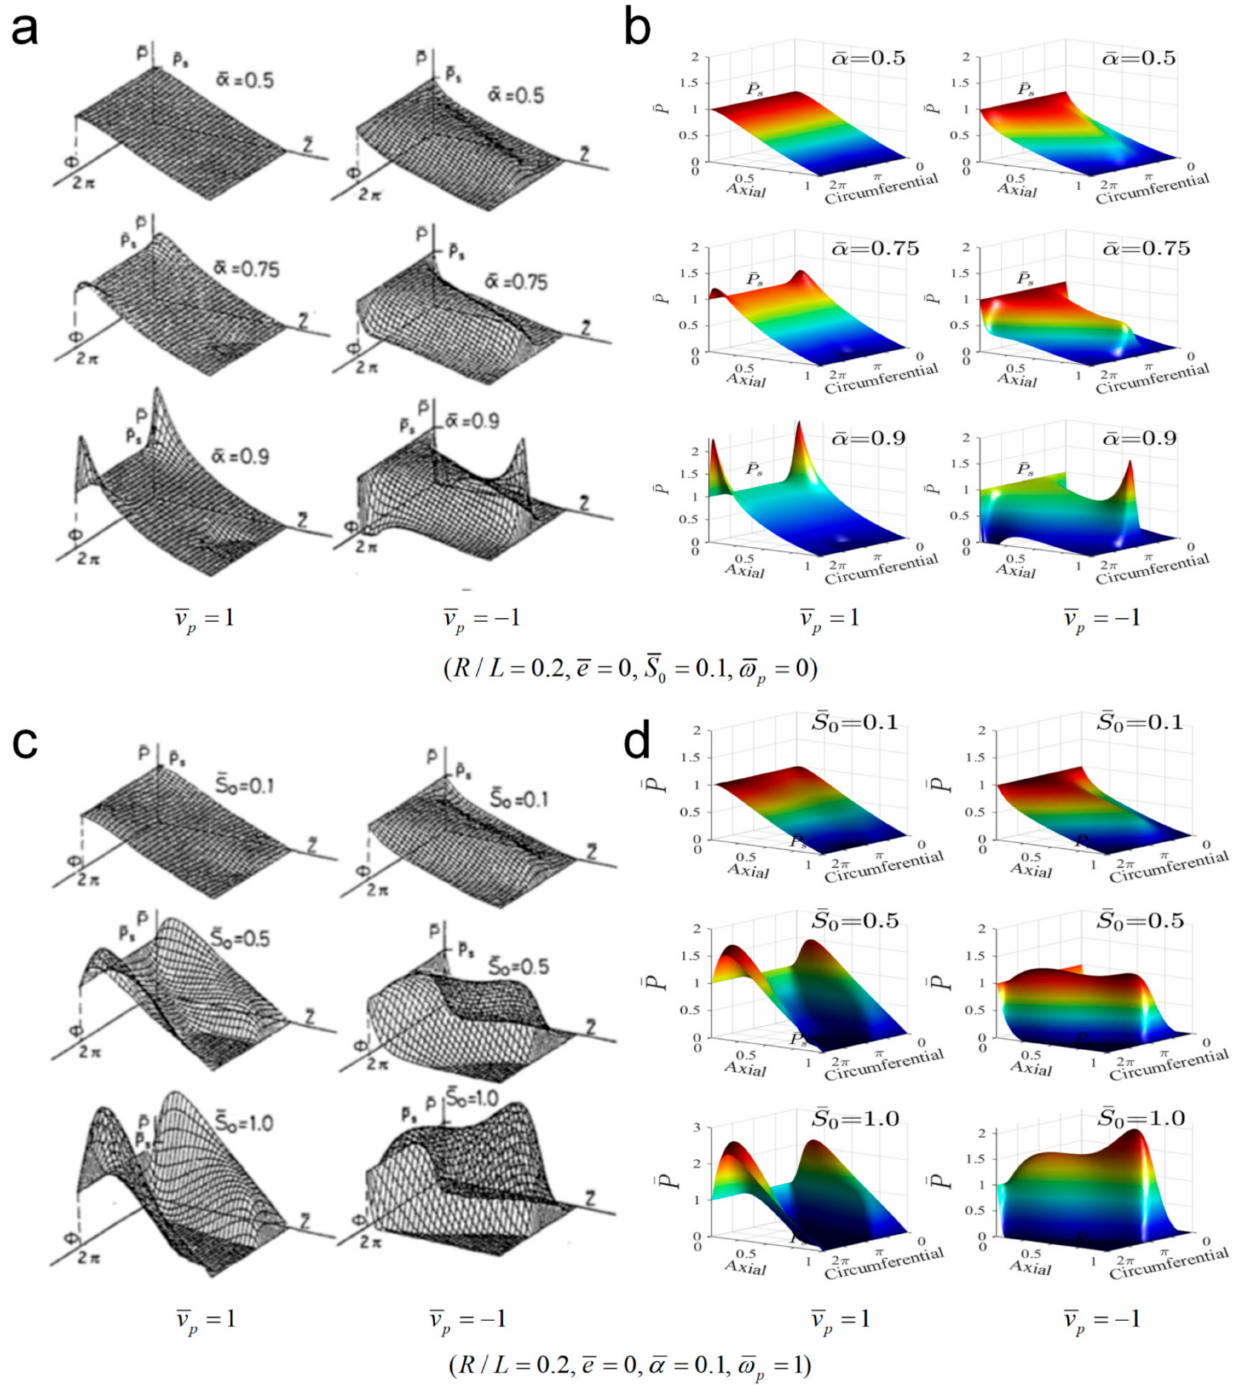
Figure 5. Distribution of oil film pressure between the piston and cylinder: ( a ) Results from [3] without considering piston spinning, ( b ) the current results without considering piston spinning, ( c ) results from [3] considering piston spinning, and ( d ) the current results considering piston